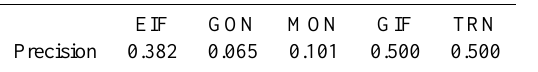
Fig. 2. MESO-NH predictions for 2m relative temperature (in ◦ C) ( a and b ), 2m relative humidity (in %) ( c and d ) and 10m wind ( e and f ) with observations shown by coloured squares/arrows for 23 March at 04:00UTC (on the left) and 11:00UTC (on the right).